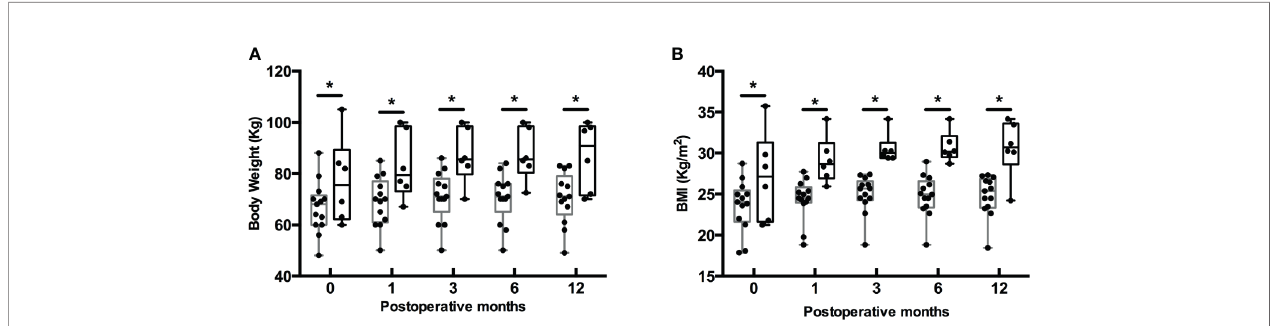
FIGURE 3 | Postoperative body weight (A) and BMI (B) at follow-up in a subset of patients who fi nished all the four follow-up time points. Gray box indicates patients without postoperative HO (n = 13), and black box indicates patients with postoperative HO (n = 6). Boxes depict the 95% con fi dence interval. Horizontal lines indicate medians. Whiskers depict the minimum and maximum data. Dots represent each individual measurement. *P <